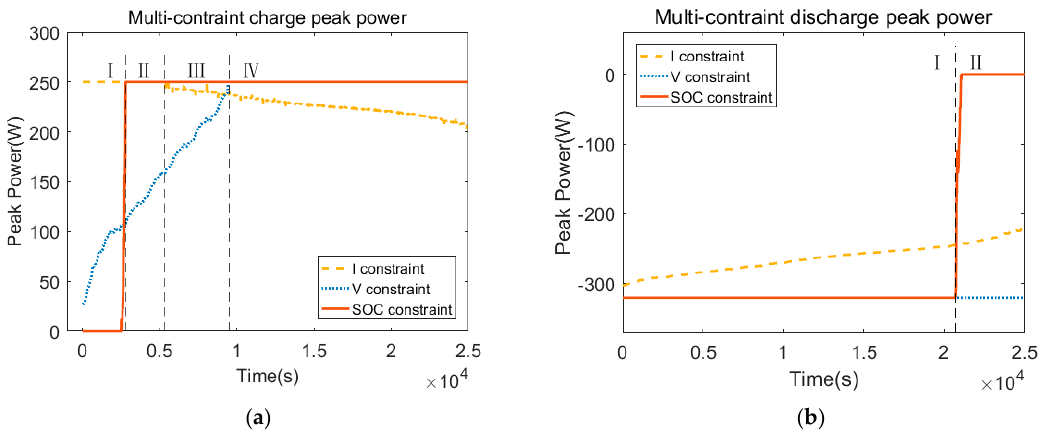
Figure 10. Battery peak power under multiple constraints: ( a ) charge peak power; ( b ) discharge peak power.